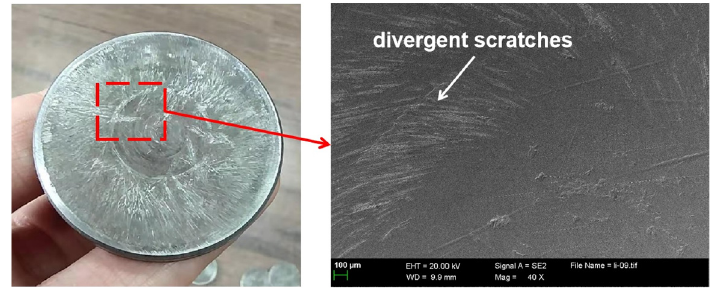
Figure 6. The worn morphology is near the center of the shim.